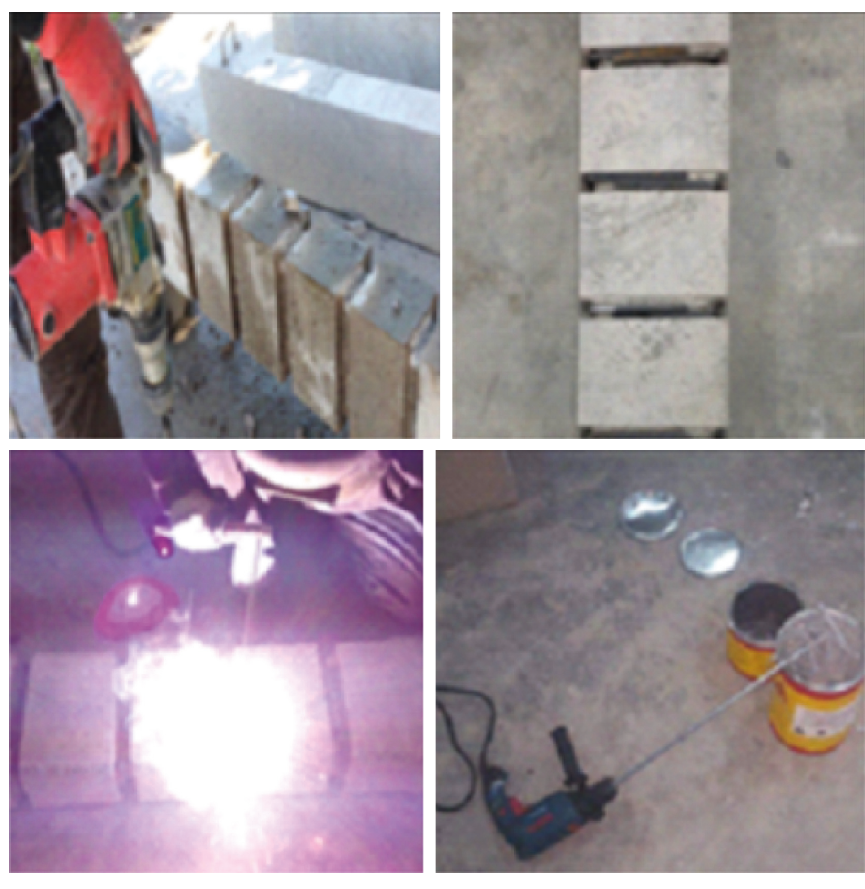
Figure 6: Grooving, NSN steel bar installation, welding, and groove filling with epoxy.